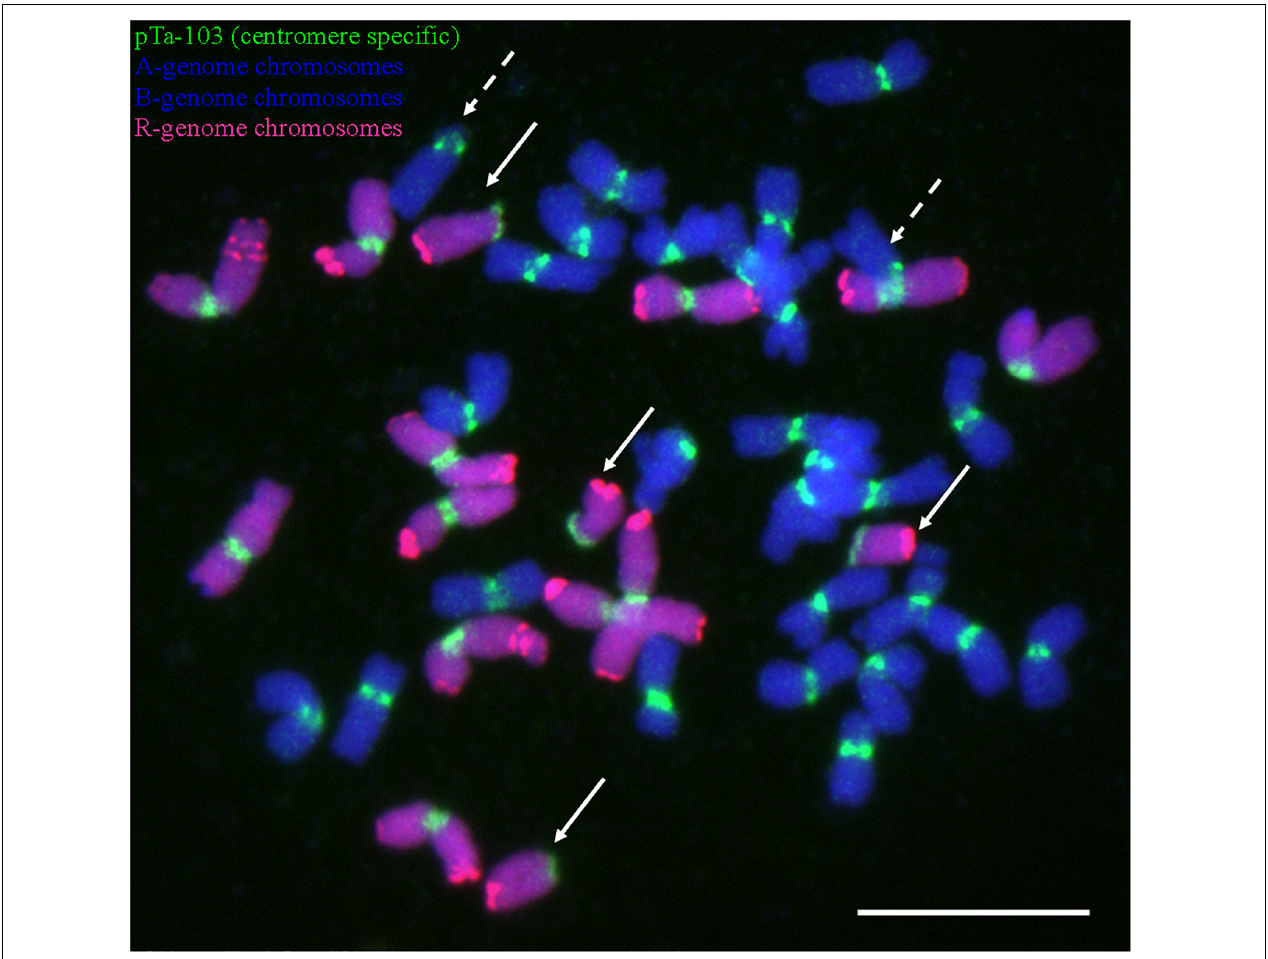
FIGURE 6 | Centric breaks of chromosomes in BC 5 F 1 plant screened using multi-color GISH/FISH. Centromere regions were mapped using pTa-103 (Atto-488, green) probe. Dotted arrows, chromosome aberrations of A- or B-genome (DAPI, blue) of triticale; solid arrows, chromosome aberrations of R-genome (Atto-550, red) of triticale. Scale bar, 10 µ